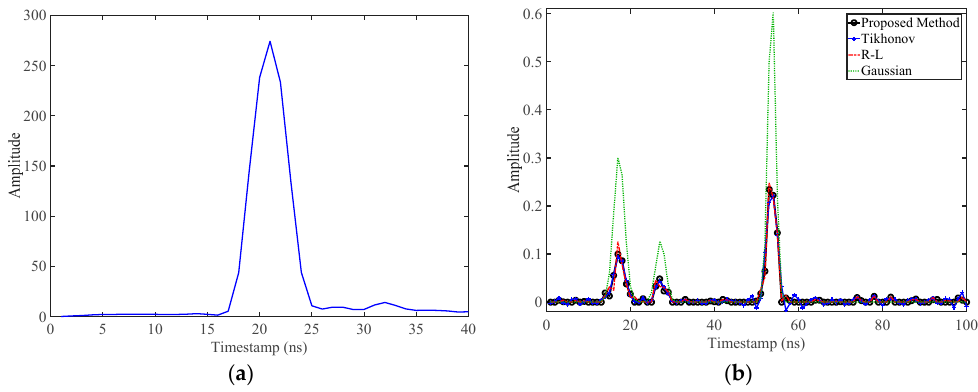
Figure 8. ( a ) Estimated system waveforms based on blind deconvolution; and ( b ) restored target responses using different methods.